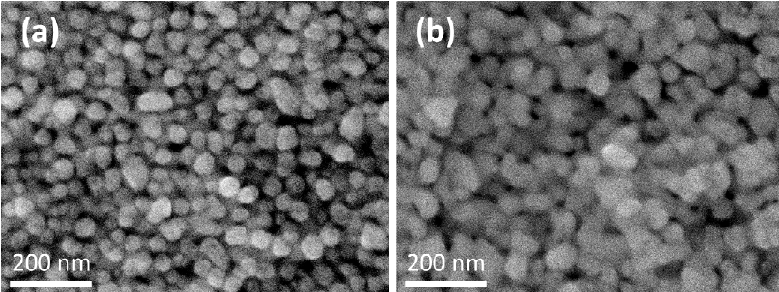
Figure 3. Field emission–scanning electron microscope (FE–SEM) images show the sintering of printed silver nanoparticles ink by the resistive heating. ( a ) The printed silver nanoparticles without annealing. ( b ) The silver nanoparticles at electrode section after annealing.